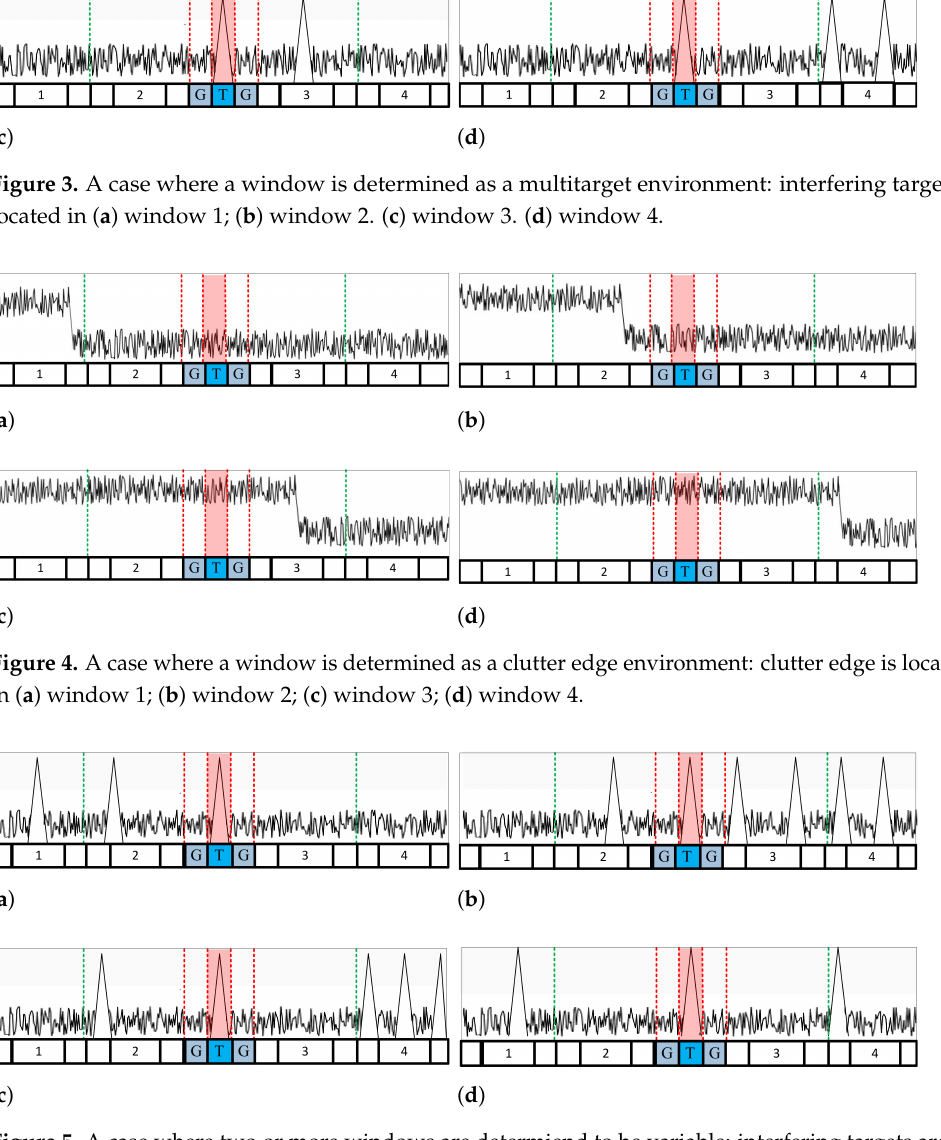
Figure 5. A case where two or more windows are determiend to be variable: interfering targets are